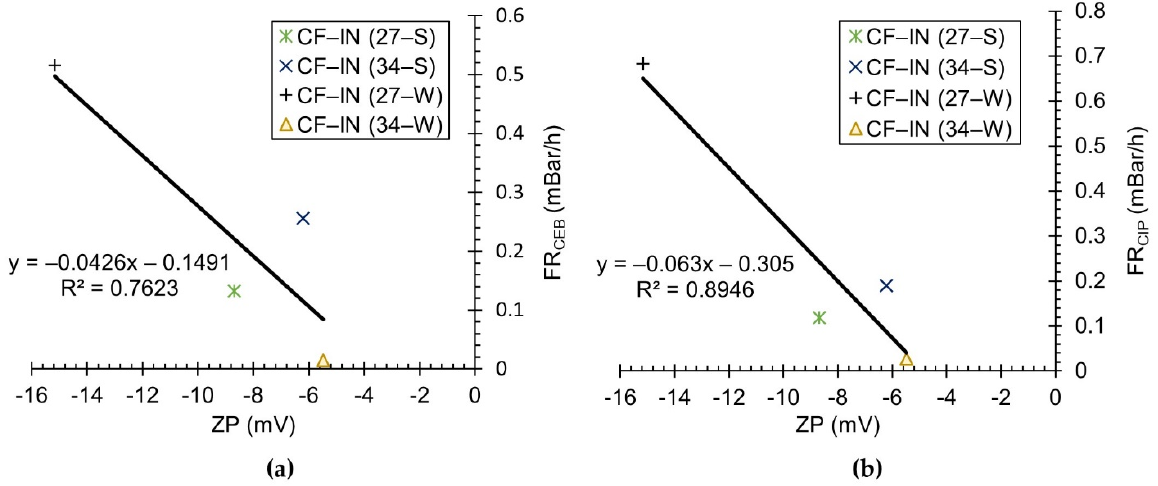
Figure 6. Relationships between zeta potential and chemically irreversible fouling: (a) following ( b ) following CEB; (b) following CIP.